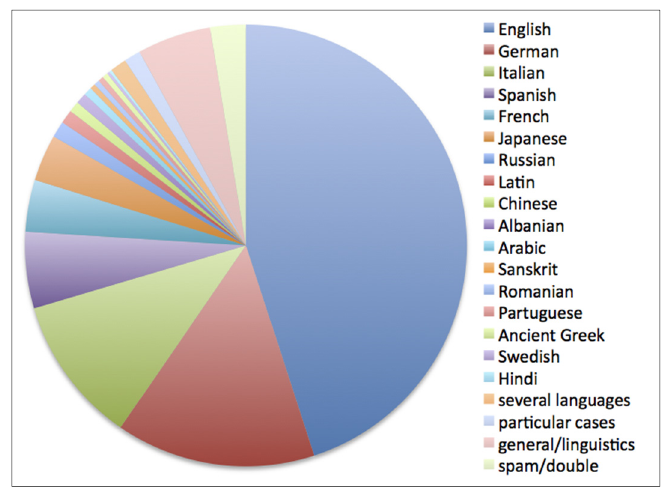
Figure 1. Occurrences of languages in the considered